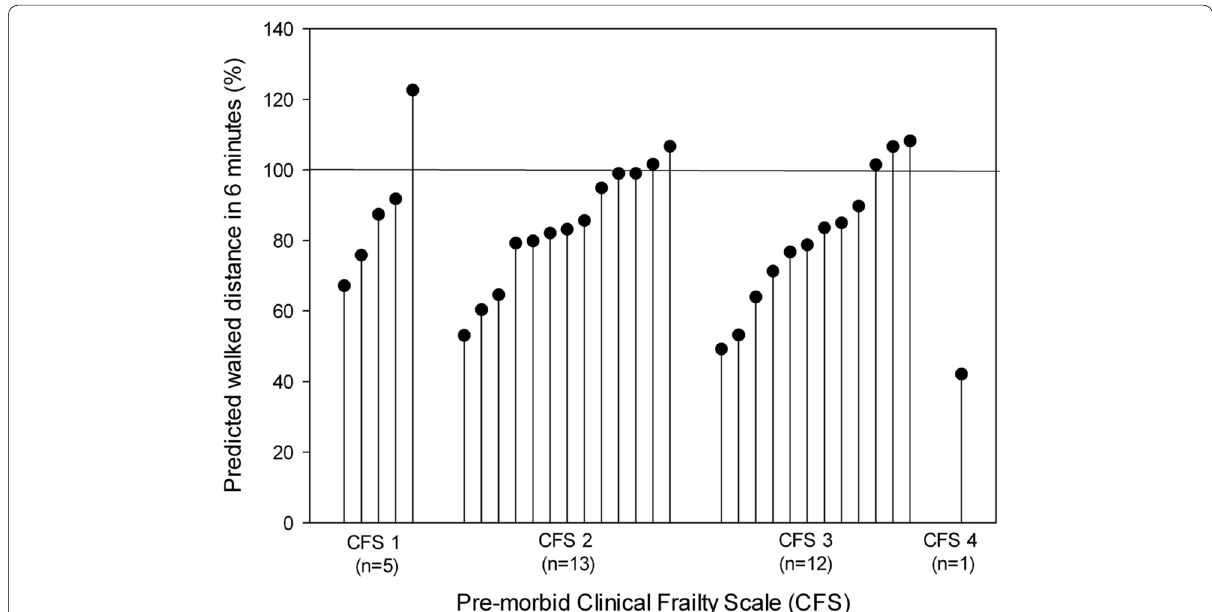
Fig. 2 Individual data (black dots) are presented as percentage of predicted values for healthy subjects of same age, sex and body mass index. Patients are grouped according to their premorbid Clinical Frailty Scale (CSF)